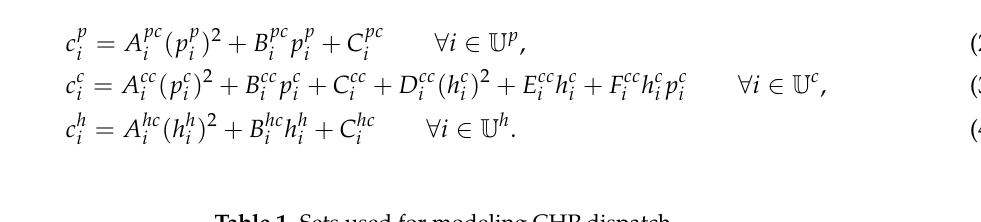
Table 1. Sets used for modeling CHP